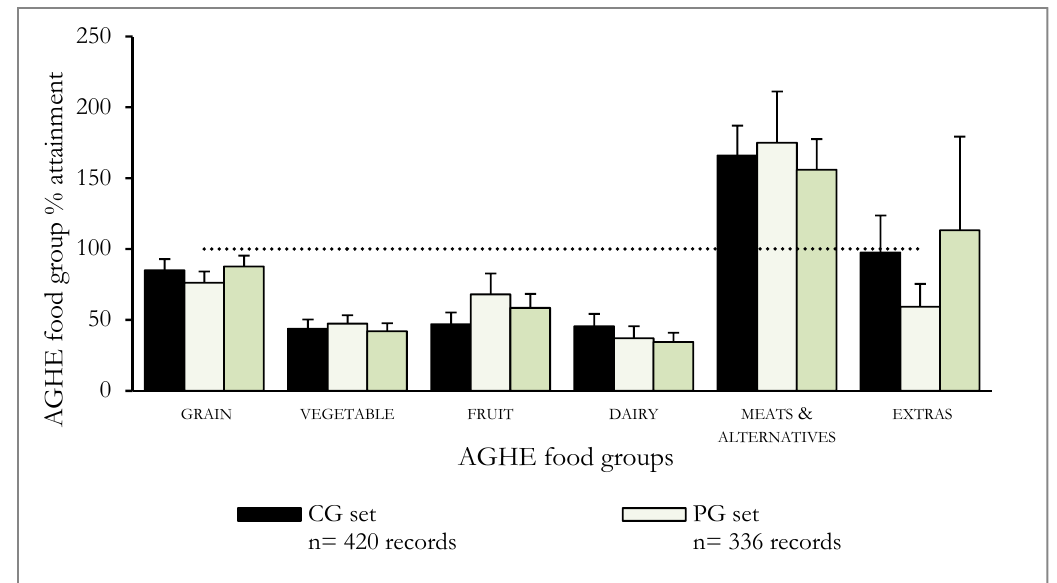
Figure 1. Consumption of Australian Guide to Healthy Eating (AGHE) food groups 1 expressed as percentage of recommendations by control (CG), pork diet (PG) and iron supplement (SG) groups. Mean of 21 days of food diary recorded over a 12-week intervention